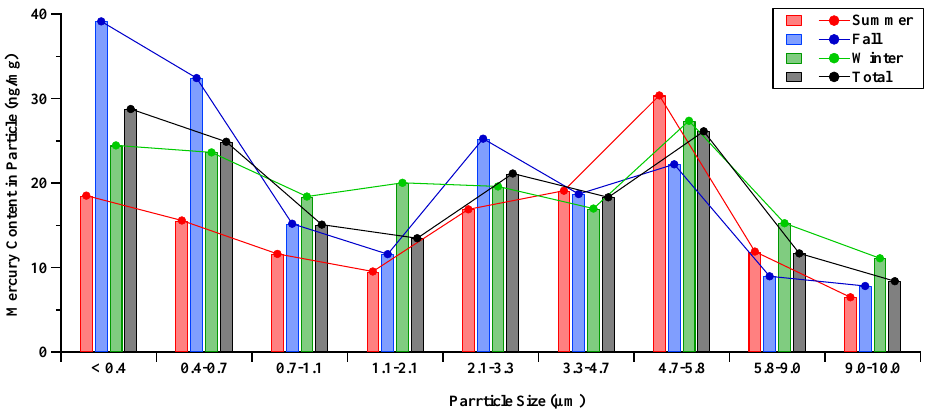
Fig. 4. Mercury content in size-fractionated particles in each season and over the whole study period.